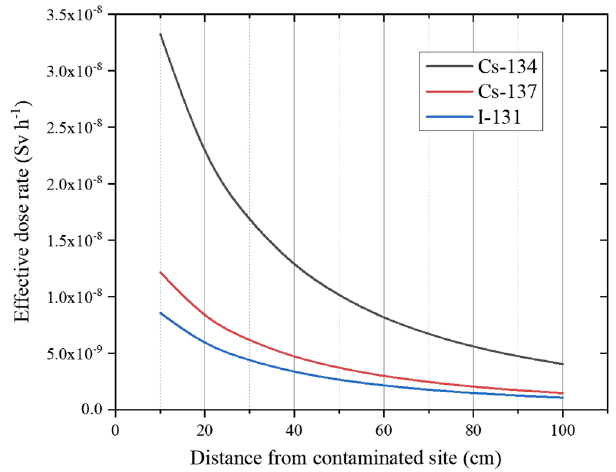
Figure 3. Exposure doses of an emergency medical responder who cares for a patient who was contaminated with radionuclides that are expected to be released during a nuclear disaster. Each of the three sources is on the surface of the body and has an intensity of 400 Bq cm −2 . Table 1 shows the detailed assumptions for this Scenario (Scenario